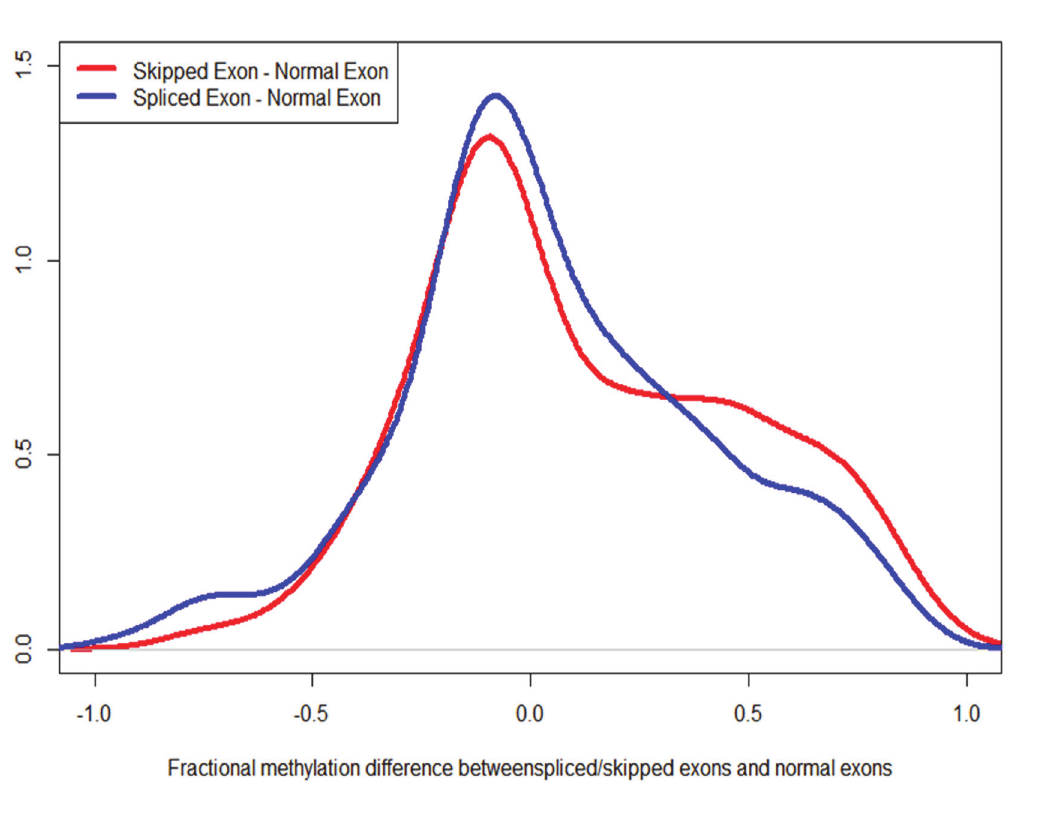
Fig 8. Alternatively spliced exons are more heavily methylated than constitutively used exons. The red curve depicts the difference in the fractional methylation levels of skipped exons (in exon-skipping events) and other exons. The blue curve depicts the difference between spliced exons (in the case of intron-retention events) and constitutively used exons. In both cases, the differences are biased towards positive, indicating that alternatively used exons are more heavily methylated.